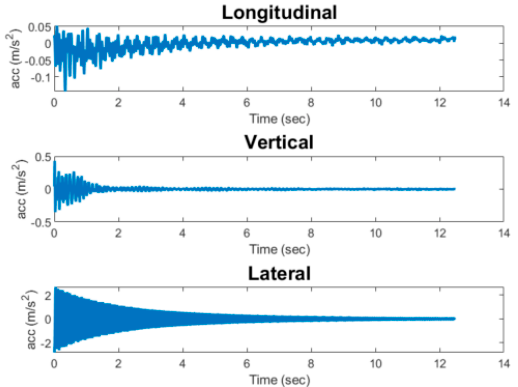
highway: ( a ) freight train; ( b ) passenger train.